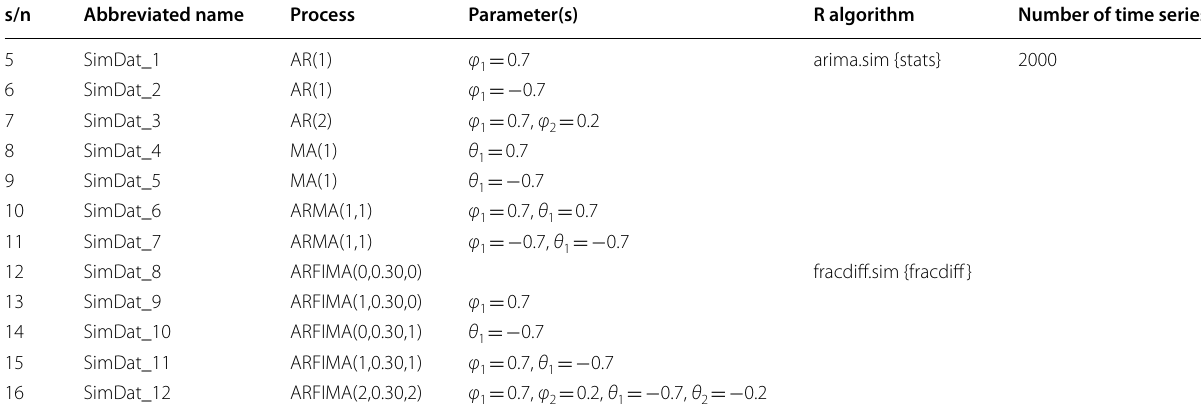
Table 3 Datasets of this study (part 2): simulated